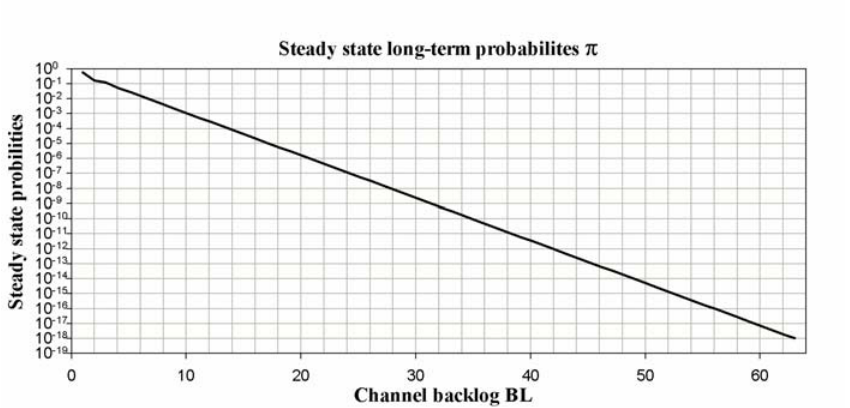
Figure 7. Distribution of steady-state long-term probabilities for backlog stages 1,…,63 in the idealized channel (noise-free and collision-free) for saturation conditions (load scenario 2). The logarithmic scale is set in the vertical axis.